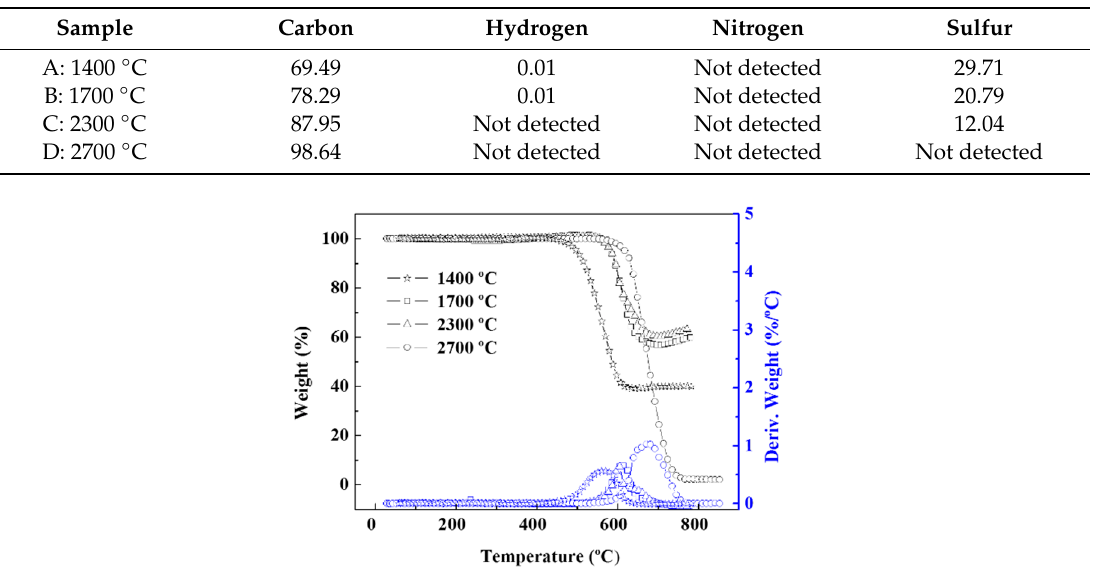
Table 5. CHNS elements analysis results of annealed soot at different temperatures (wt%).